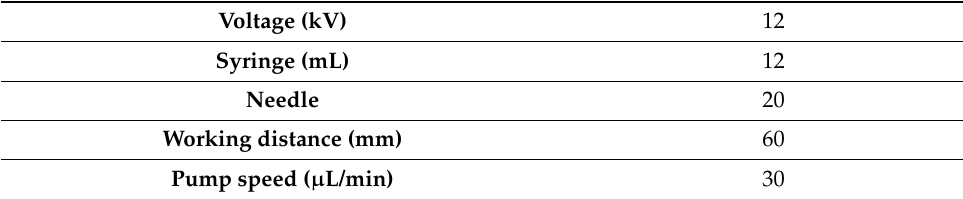
Table 4. Input parameter of the electrospinning process.